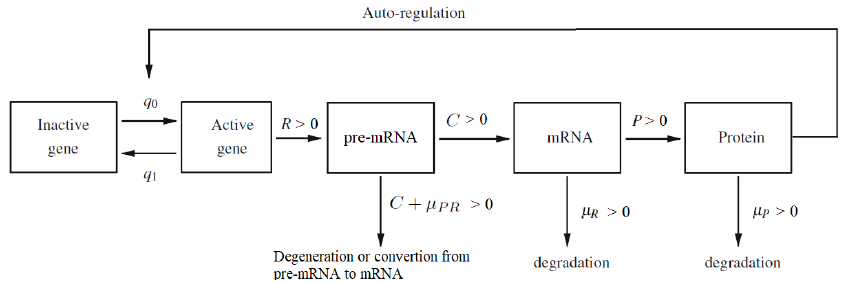
Figure 1. The diagram of auto-regulated gene expression with pre-mRNA, mRNA and protein contribution. Description of the parameters: q 0 and q 1 are switching intensity functions; R is the speed of synthesis of pre-mRNA molecules if the gene is active; C is the rate of converting pre- mRNA into active mRNA molecules; P is the rate of converting mRNA into protein molecules; µ PR is the pre-mRNA degradation rate; µ R is the mRNA degradation rate; µ P is the protein degradation rate. The sum C + µ PR should be treated as a total degradation rate of the pre-mRNA